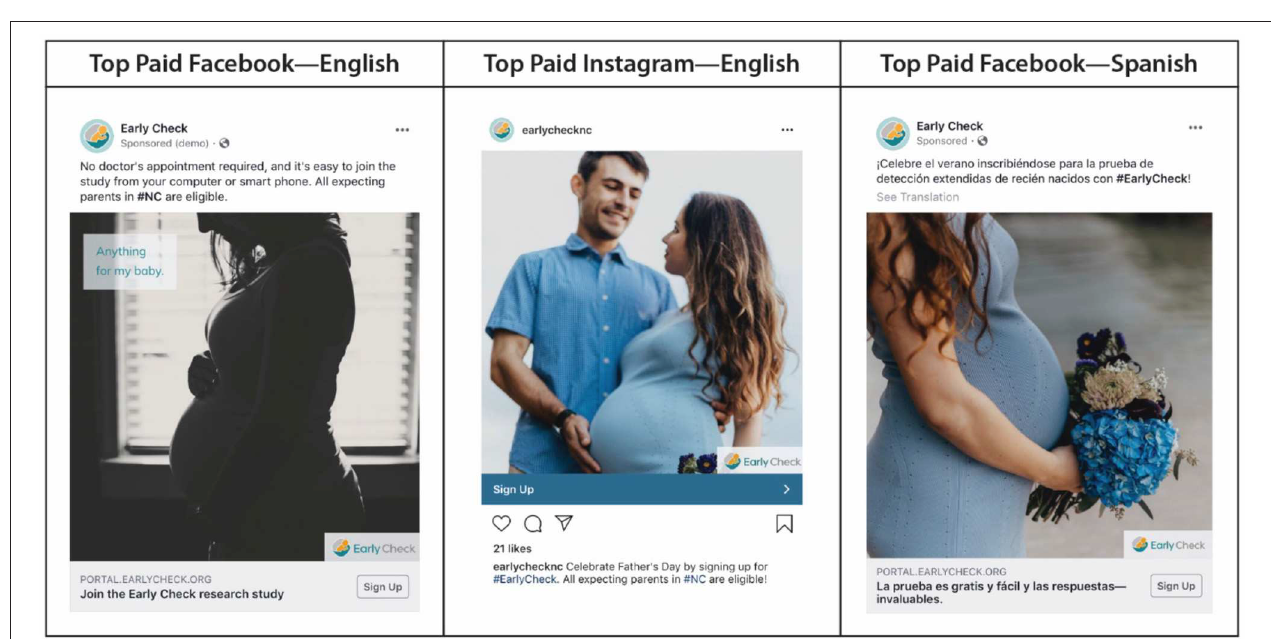
FIGURE 2 | Top-performing paid social media ads.